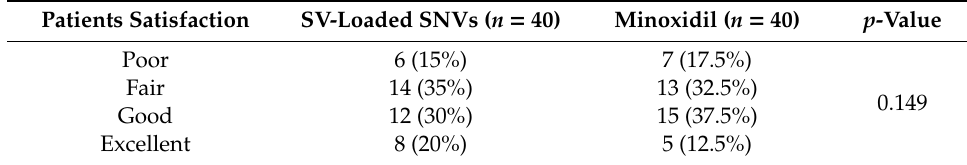
Table 8. Patient satisfaction in the studied groups at the end of the study. Patients Satisfaction